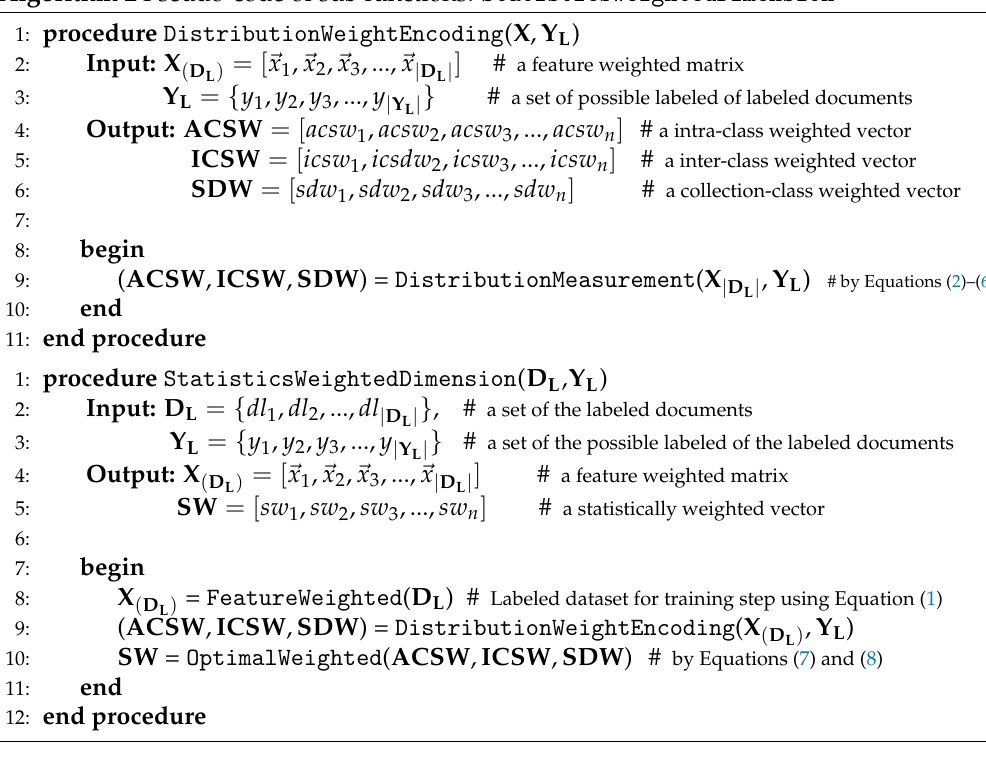
Algorithm 2 Pseudo-code of sub functions: